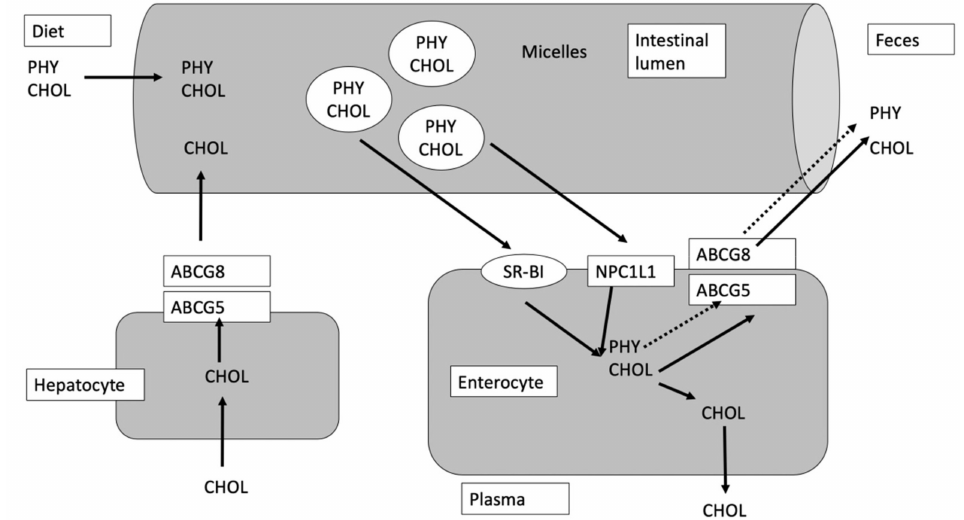
Figure 2. Transport mechanism of CHOL (cholesterol) and PHY (phytosterols), modified from